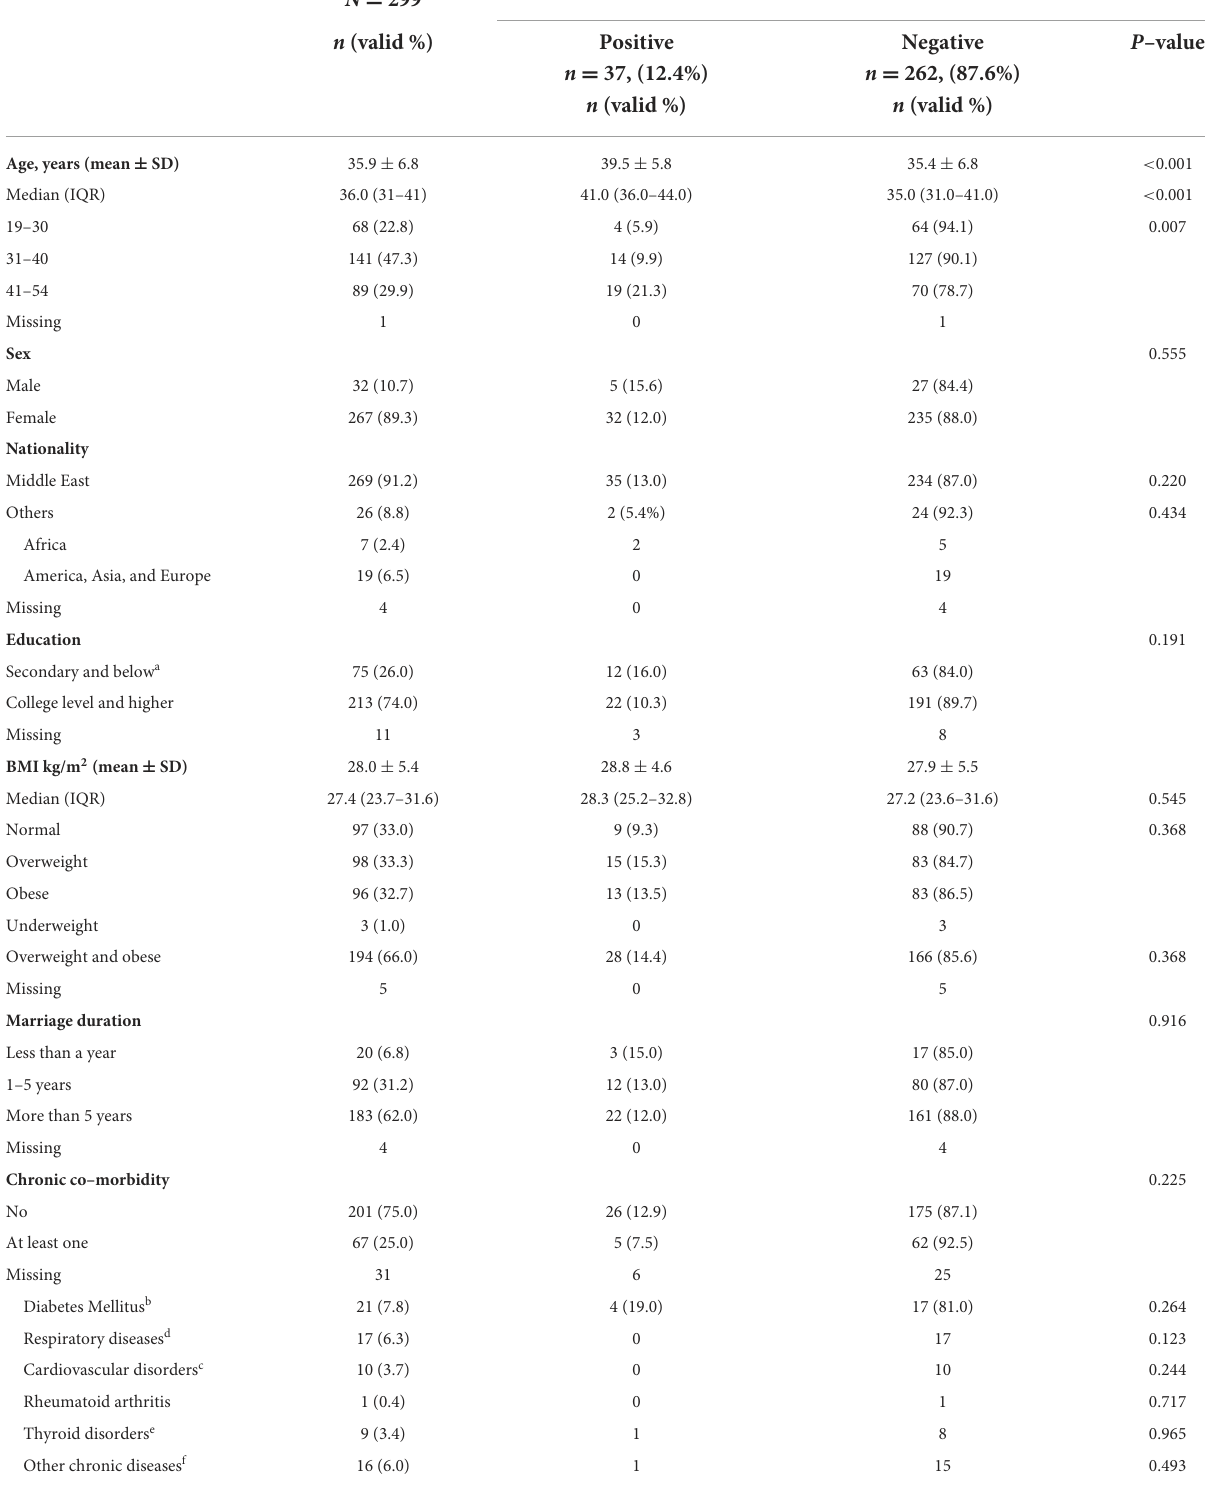
TABLE 1 Prevalence of HSV-2 IgG antibodies according to the sociodemographic and medical characteristics of the fertility clinics’ attendees and the crude association with being